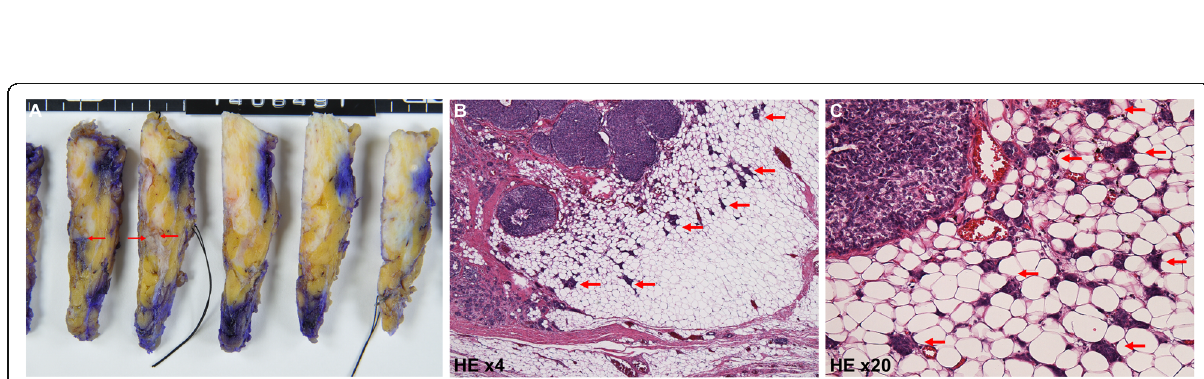
Fig. 2 Core needle biopsy histological findings of the tumor ( a ) and ( b ) HE-stained sections at × 4 and × 20 magnification. a Low-power view illustrates a solid papillary carcinoma. b High-power view demonstrates the rosette structure of a solid papillary growth pattern and a network of thick fibrovascular cores among proliferating atypical malignant cells. c Positive immunohistochemical staining findings for the estrogen receptor. Positive immunohistochemical staining findings for the following markers demonstrate the neuroendocrine component of the tumor: d neuron- specific enolase, e chromogranin, and f synaptophysin. g Negative immunohistochemical staining for the myoepithelial marker p63 ( a : × 4, b – g : × 20)